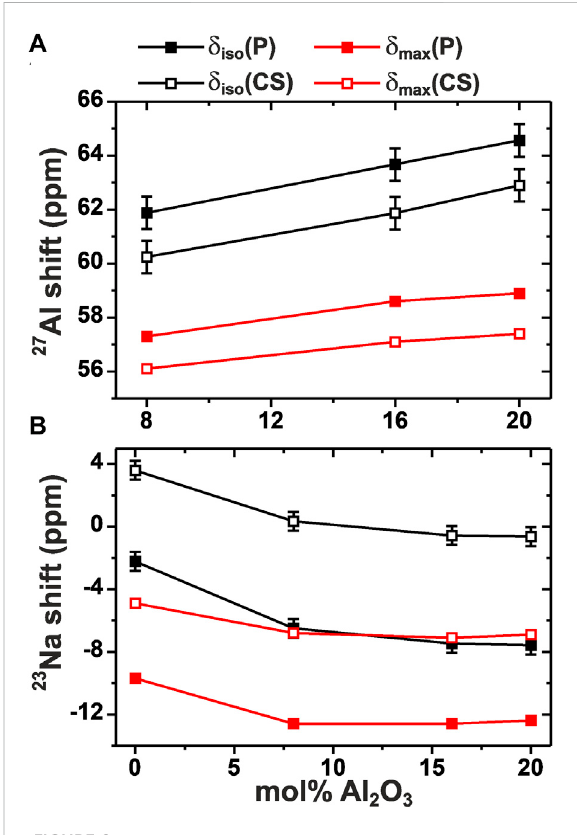
FIGURE 2 Average isotropic chemical shift ( δ iso ) and the shift at the NMR-peak maximum ( δ max ) plotted against the mol% of Al 2 O 3 in the glass for (A) 27 Al and (B) 23 Na. “ P ” refers to results from the pristine glasses and “ CS ” to those obtained after chemical strengthening; see Table